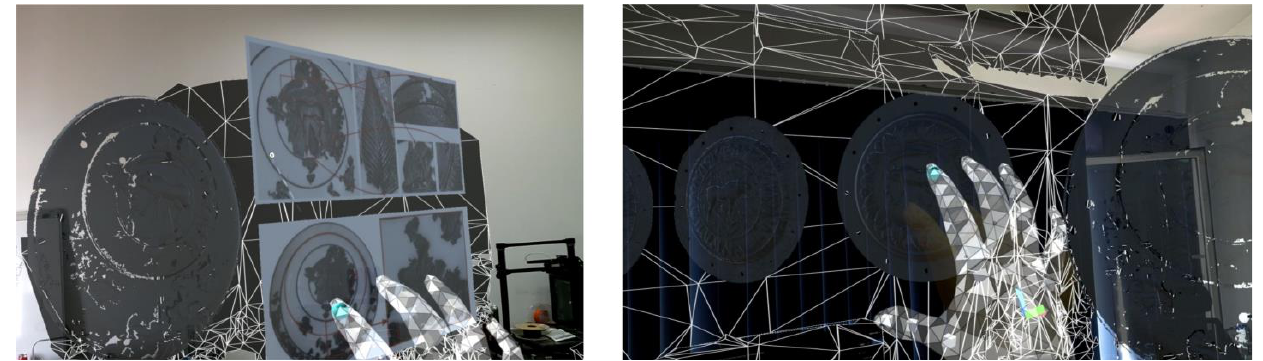
Figure 29. The developed mixed reality application for Hololens 2, intended to disseminate the 3D reconstructions of the Dacian embossed